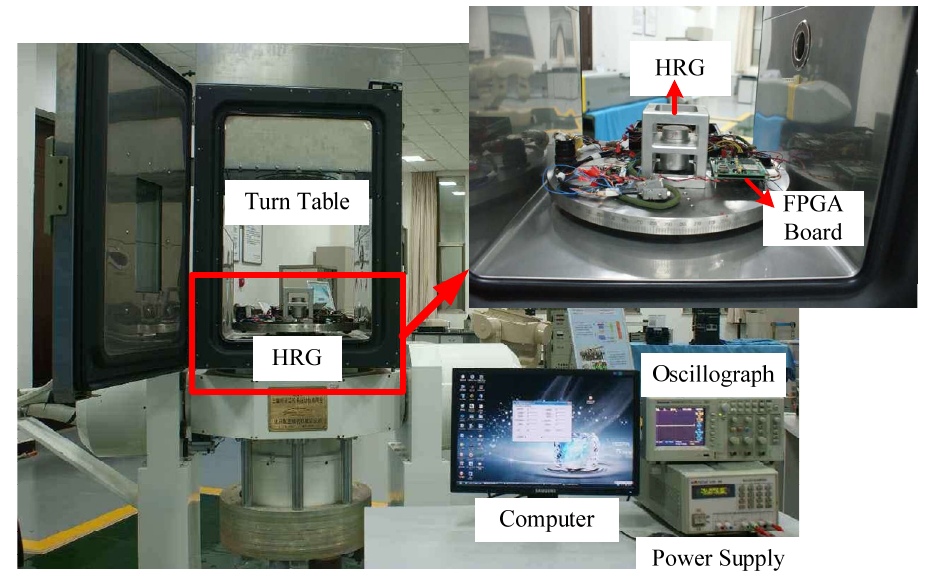
Figure 6. The experimental setup of the gyro.